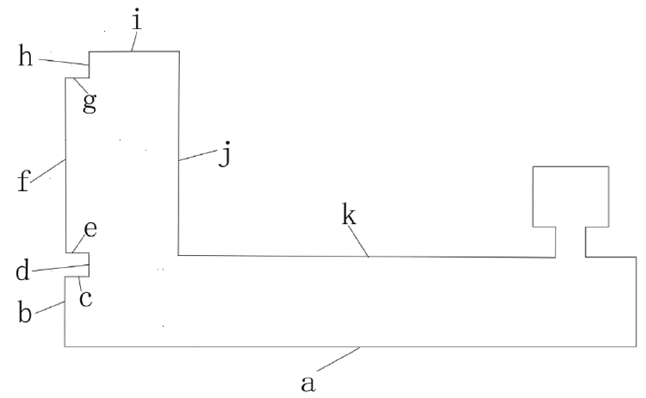
Figure 25. Schematic figure of simulation scene.